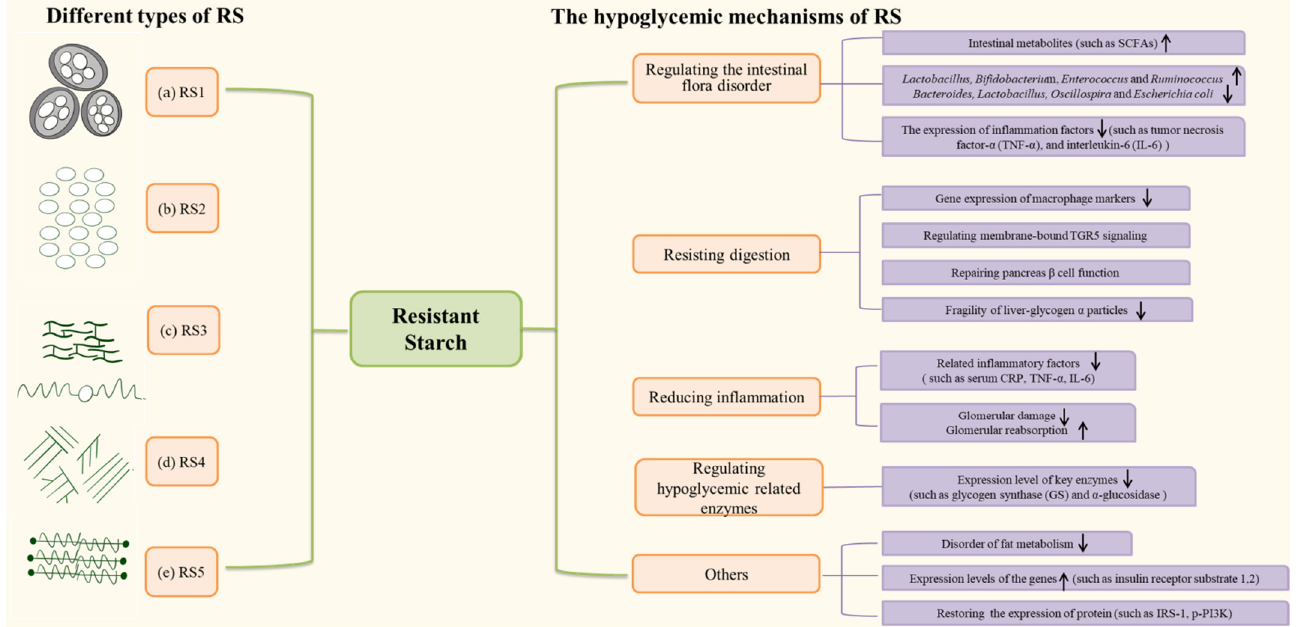
Figure 1. Different types of, and the potential hypoglycemic mechanisms of RS. ( a ) RS1, the most common RS found in all grains, is a kind of physically inaccessible starch.; ( b ) RS2, in raw potato or high-amylose maize, has a B- or C-type polymorph; ( c ) RS3, in cooked and cooled potatoes, a kind of retrograded starch; ( d ) RS4, chemically modified starch, through the addition of cross-linkages or chemical derivatives; ( e ) RS5, in processing or cooking oil, a lipid-modified starch. Adapted from Wong et al. [10].